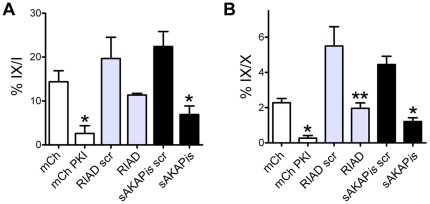
PKA activity and anchoring are required for SKOV-3 cell invasion.(A, B) SKOV-3 cells were transiently transfected with plasmids to inhibit PKA activity or anchoring (mCh-PKI, GFP-RIAD, GFP-sAis) or their respective controls (Empty mCh, GFP-RIAD_scr, GFP-sAis_scr), then subject to invasion analysis as described in Figures 3 and 4. (* = P<0.01; ** = P<0.05). In parallel to the method described in Figure 3, invasion was calculated as the average percentage (± S.E.) of invading transfected cells over the total number of invading cells (A; ‘IX/I’) or, to normalize for transfection efficiency, the average percentage of invading transfected cells over the total number of transfected cells (B; ‘IX/X’).